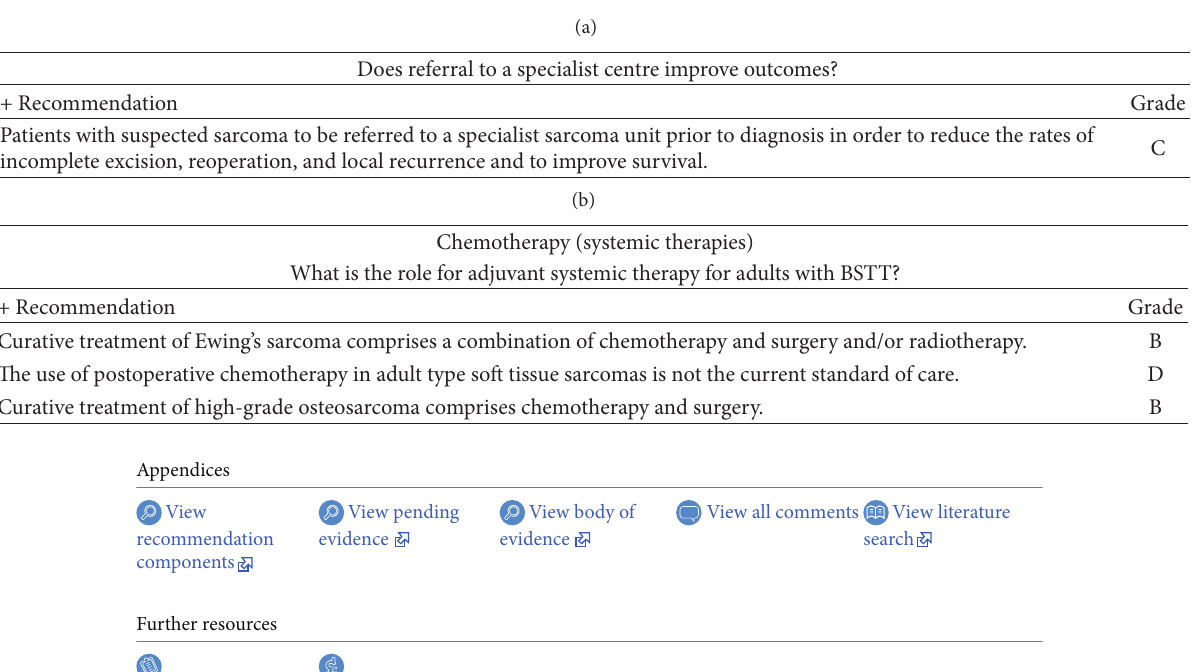
Table 1: Excerpt of summary of recommendations.